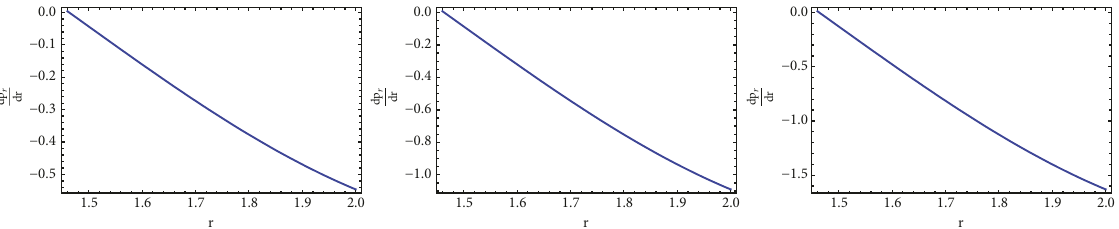
Figure 7: This figure represents the variation of 𝑑𝑝 𝑟 /𝑑𝑟 versus 𝑟 (km) for strange the star taking 𝛽 = 1 , 𝛽 = 2 , and 𝛽 = 3 .